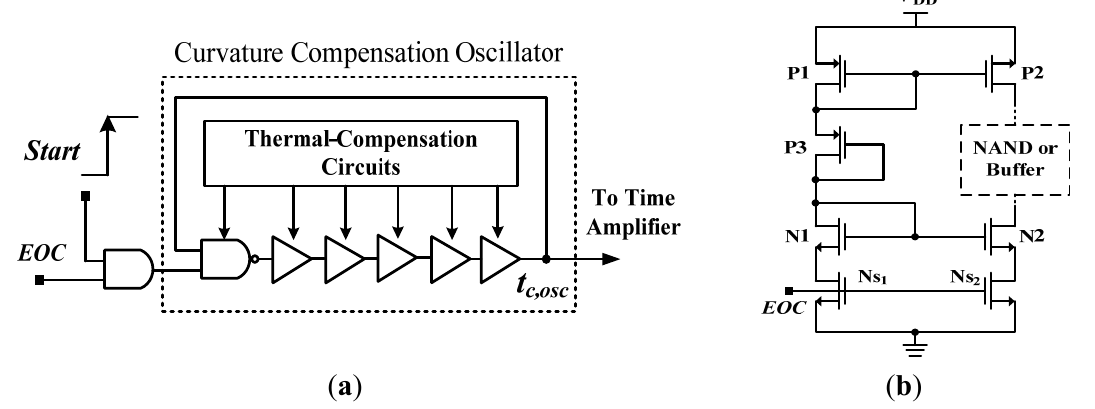
Figure 7. Schematics of ( a ) Curvature compensation oscillator and ( b ) Adopted thermal-compensation